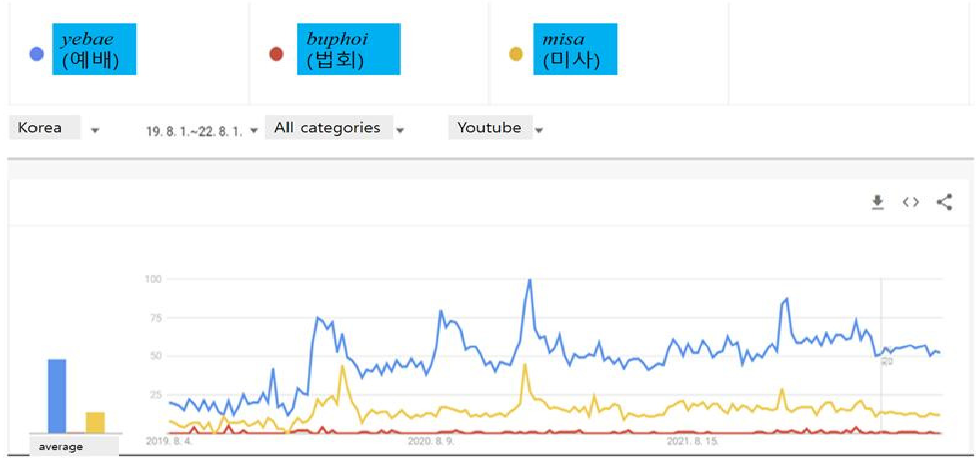
Figure 1. Change in Google Trends of Worship Services in